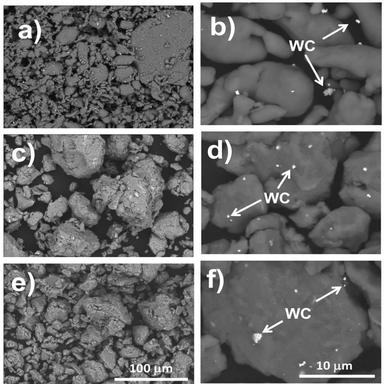
SEM-BSE images of Al-Cu-Mg/WC composite powders after different milling times: a–b) 0 h, c–d) 3 h, and e–f) 5 h.